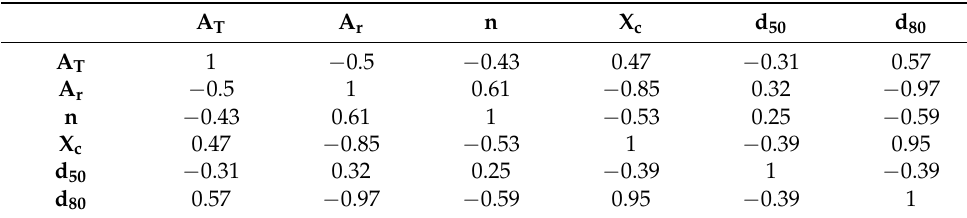
Table 5. Correlation between variables.